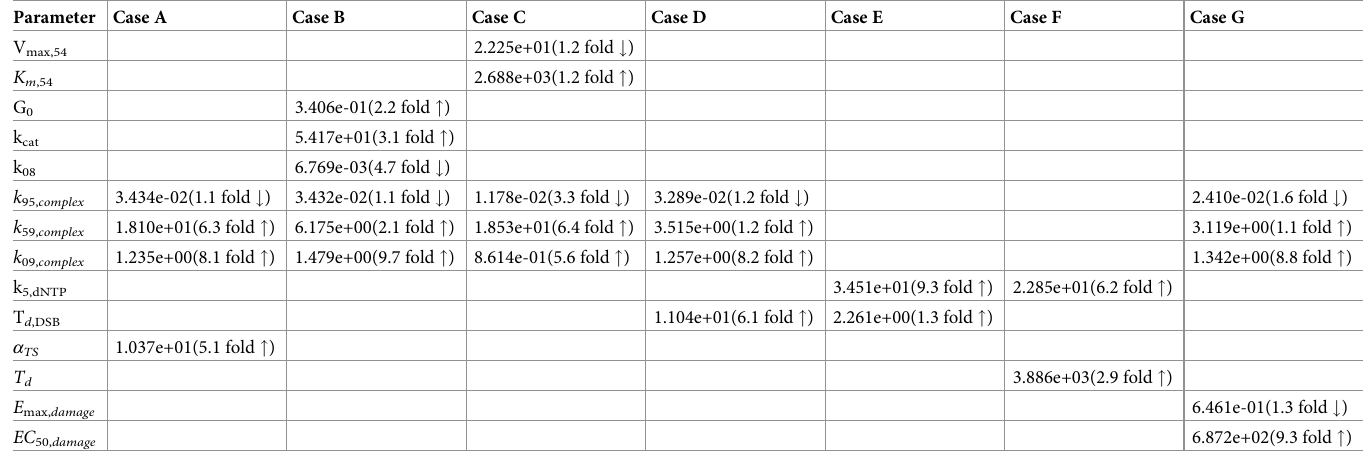
Table 7. Values and fold change from the baseline of the 11 parameters considered in resistance analysis producing the simulations closest to the time course of resistant LS174T xenograft tumor. Parameter Case